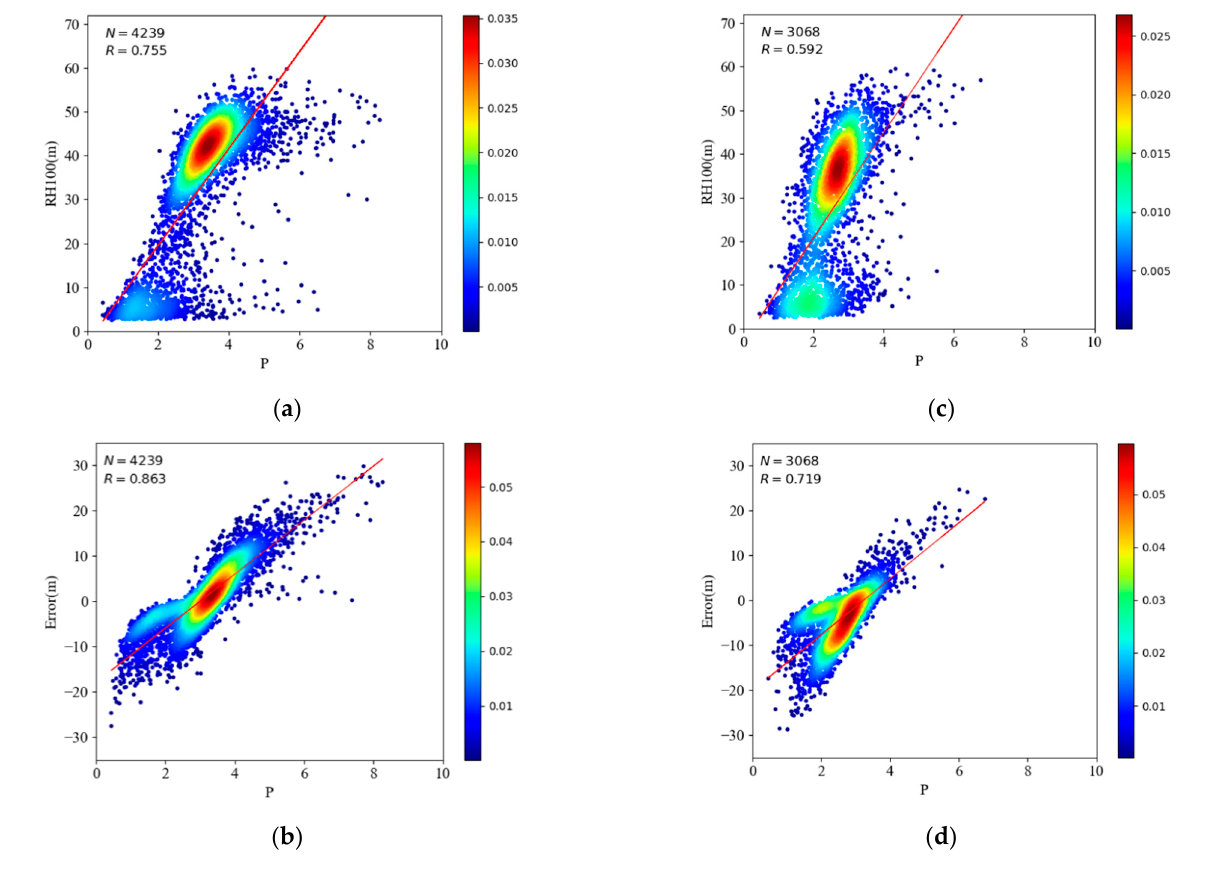
Figure 10. Scatter plots of p -values vs. error and RH100 for the Lope ( a , b ) and Pongara ( c , d ) test areas.